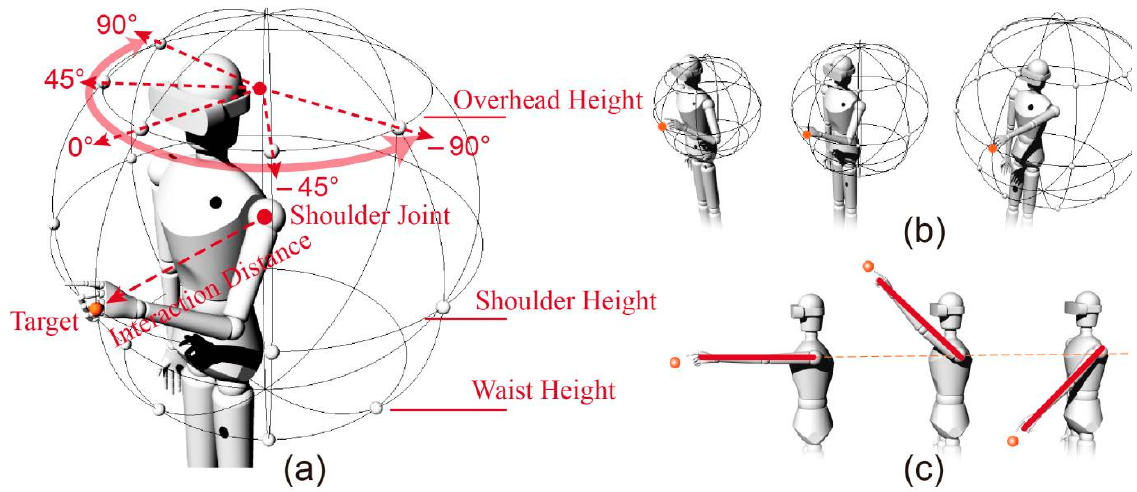
Figure 4. An illustration of the independent variables: ( a ) 15 target positions; ( b ) three operational distances corresponding to three bending degrees of the arm; ( c ) hand-operational heights (overhead, shoulder, and waist).